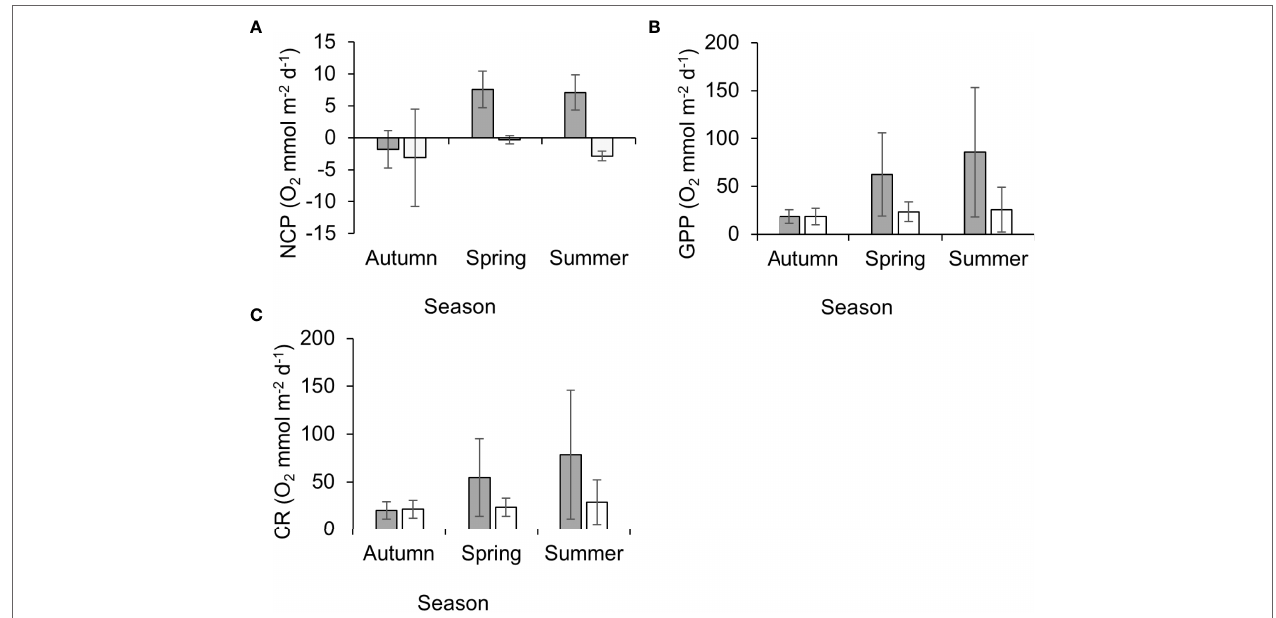
FIGURE 3 | (A) Net community productivity (NCP), (B) Gross primary productivity (GPP) and (C) Community respiration (CR) of P. oceanica meadow edge (grey) and bare sand incubations (White) determined across seasons with large benthic chambers; autumn (November), spring (April) and summer (July). Error bars represent standard deviation (autumn and spring n = 3, summer n =